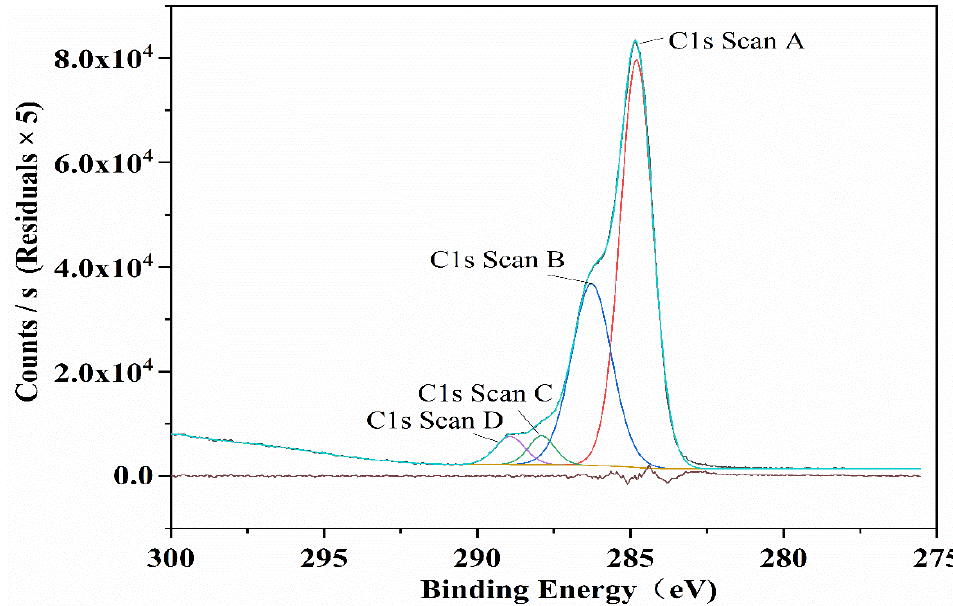
Figure 10. XPS C1 S energy spectrum of CMC-O-PKO-ECH.